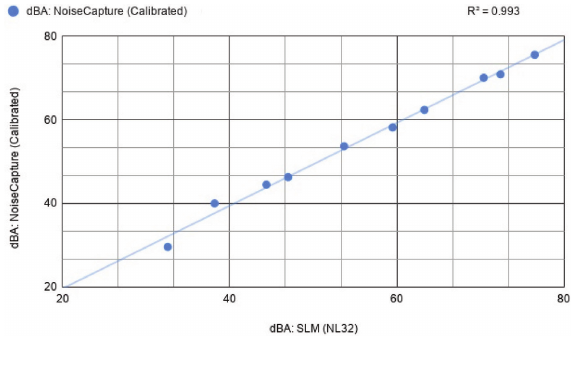
Results of the accuracy check of NoiseCapture. The vertical axis shows the values measured by NoiseCapture, and the horizontal axis shows those measured by a Class 1 SLM (RION, NL-32). The line shows linear regression (R 2 =